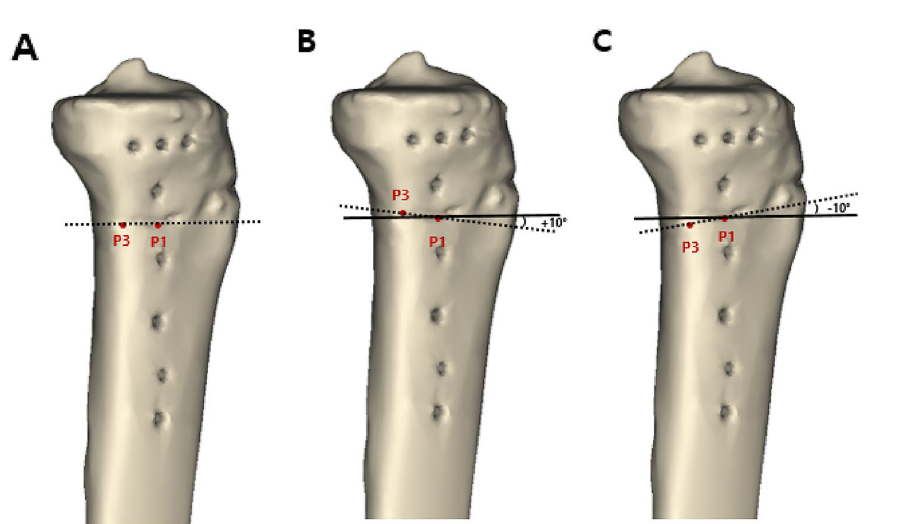
Figure 3. In the sagittal plane, the angle between the dotted line formed by P1 and P3 and the solid line parallel to the medial tibial plateau line was defined as the osteotomy inclination angle. ( A ) Parallel osteotomy line (0°). ( B ) Anteriorly inclined osteotomy line (10°). ( C ) Posteriorly inclined osteotomy line (− 10°). These figures were created using the Mimics software (version 17; Materialise, Leuven,